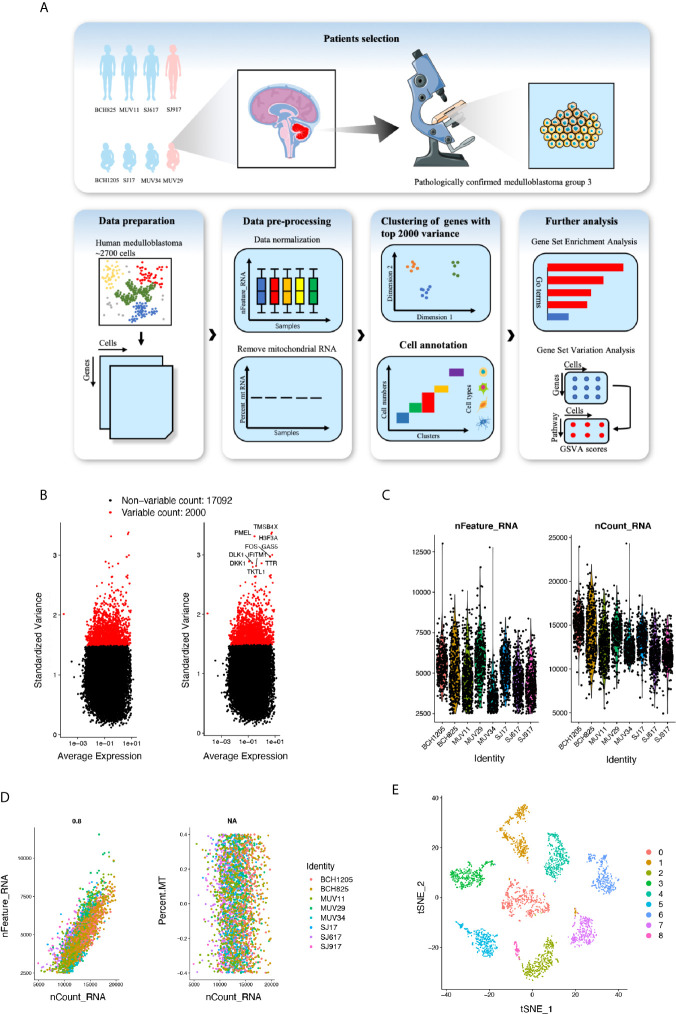

(A) Overall data analysis process of single-cell transcriptome expression landscape of Group 3 medulloblastoma (MB) (n=8). (B) Genes with top 2000 standard variance selected for subsequent analysis. (C) Violin plot of RNA features, and RNA counts in patients with MB. (D) Scatter plot of expression level of mitochondrial RNA, RNA features and RNA counts. (E) T-distributed stochastic neighbor embedding (t-SNE) plot of Group 3 MB cells revealing 0–8 cell clusters.